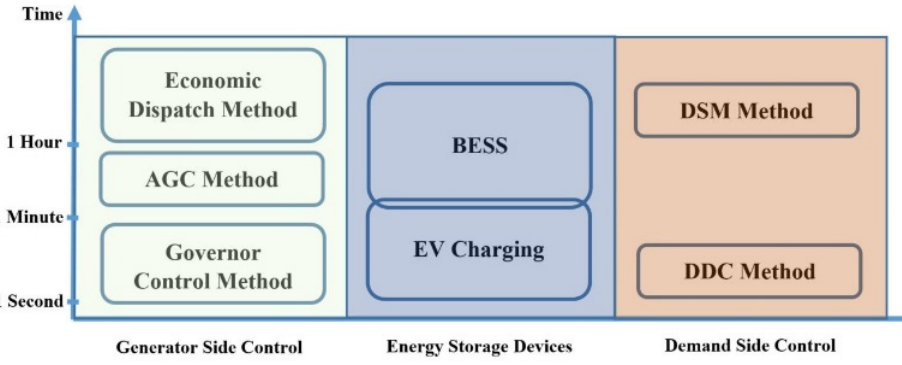
Figure 2. General techniques for regulating frequency in RES-based power systems.